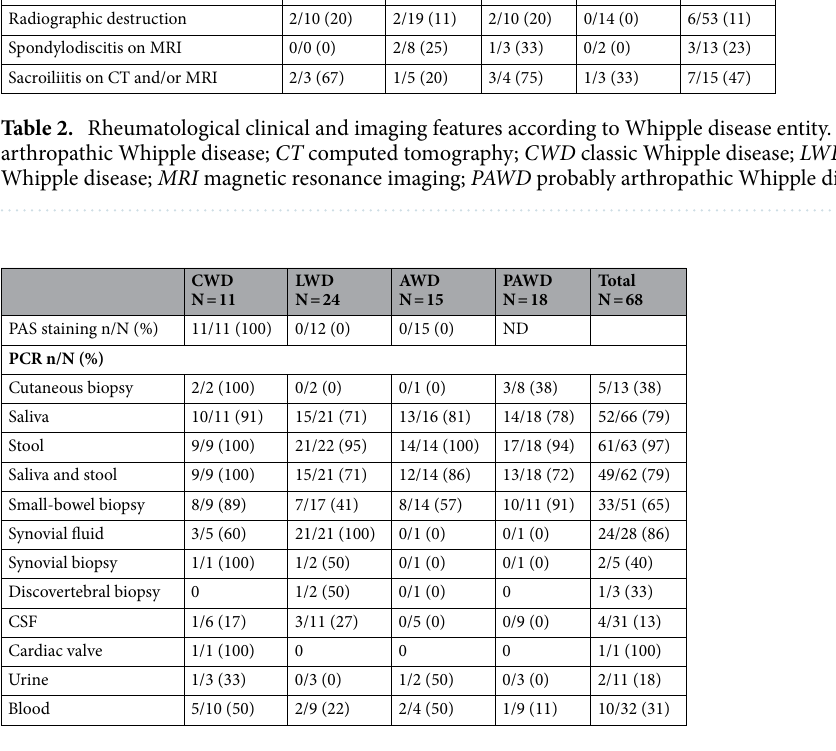
Table 3. Diagnostic methods according to Whipple disease entity. AWD arthropathic Whipple disease; CSF cerebrospinal fluid; CWD classic Whipple disease; LWD localized Whipple disease; PAS periodic acid-Schiff; PAWD probably athropathic Whipple